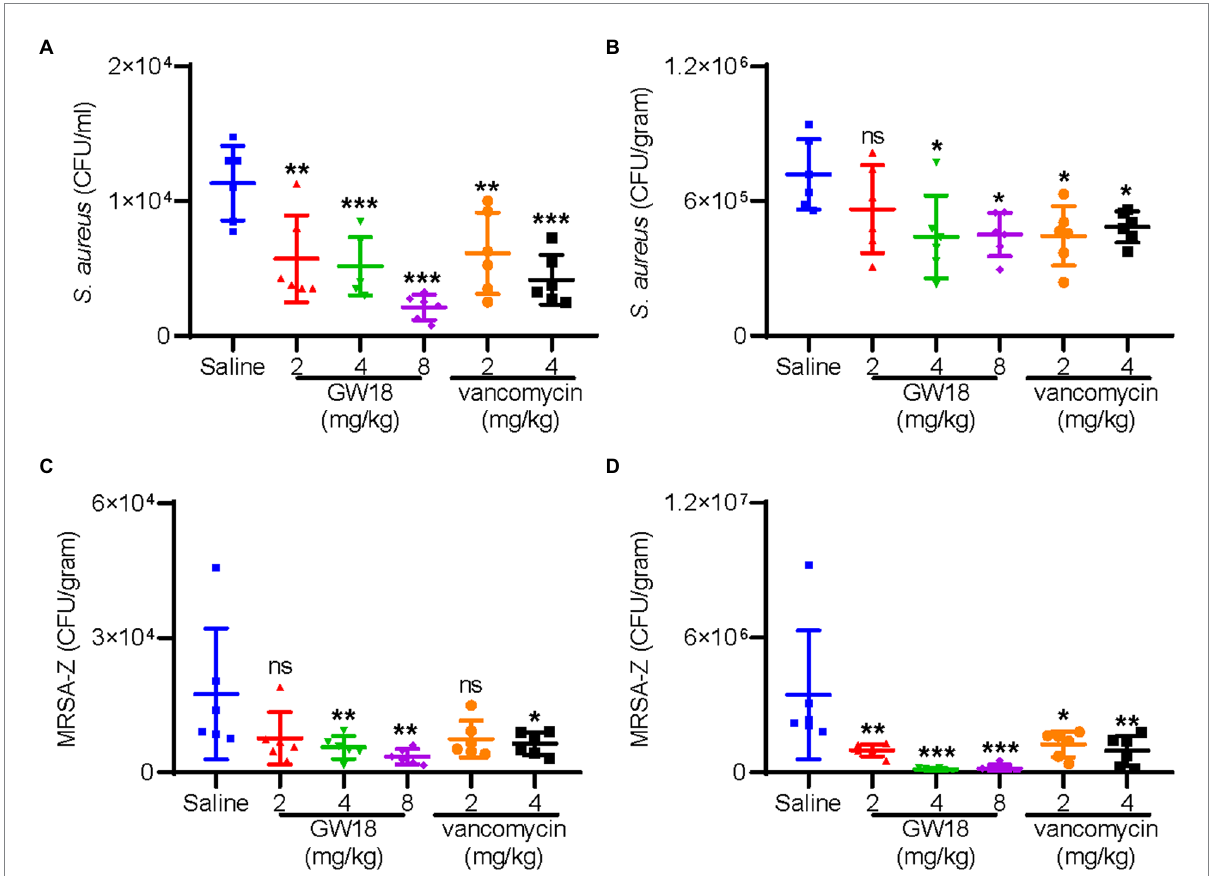
FIGURE 5 GW18 suppresses the dissemination of S. aureus (ATCC6538) and MRSA-Z in vivo . Mice ( n = 6) were injected with S. aureus (ATCC6538 or MRSA-Z, 2 × 10 8 CFU/mouse, ip), 2 h later, samples (GW18: 2, 4, 8 mg/kg; vancomycin: 2, 4 mg/kg, saline as the negative control group) were intraperitoneally injected with the concentration indicated. After 4 h of administration, mice were sacrificed, blood (A,C) and lung (B,D) were collected for the measurement of bacterial loads. Data represent mean ± SD values of six independent experiments. * p < 0.05, ** p < 0.01, *** p <